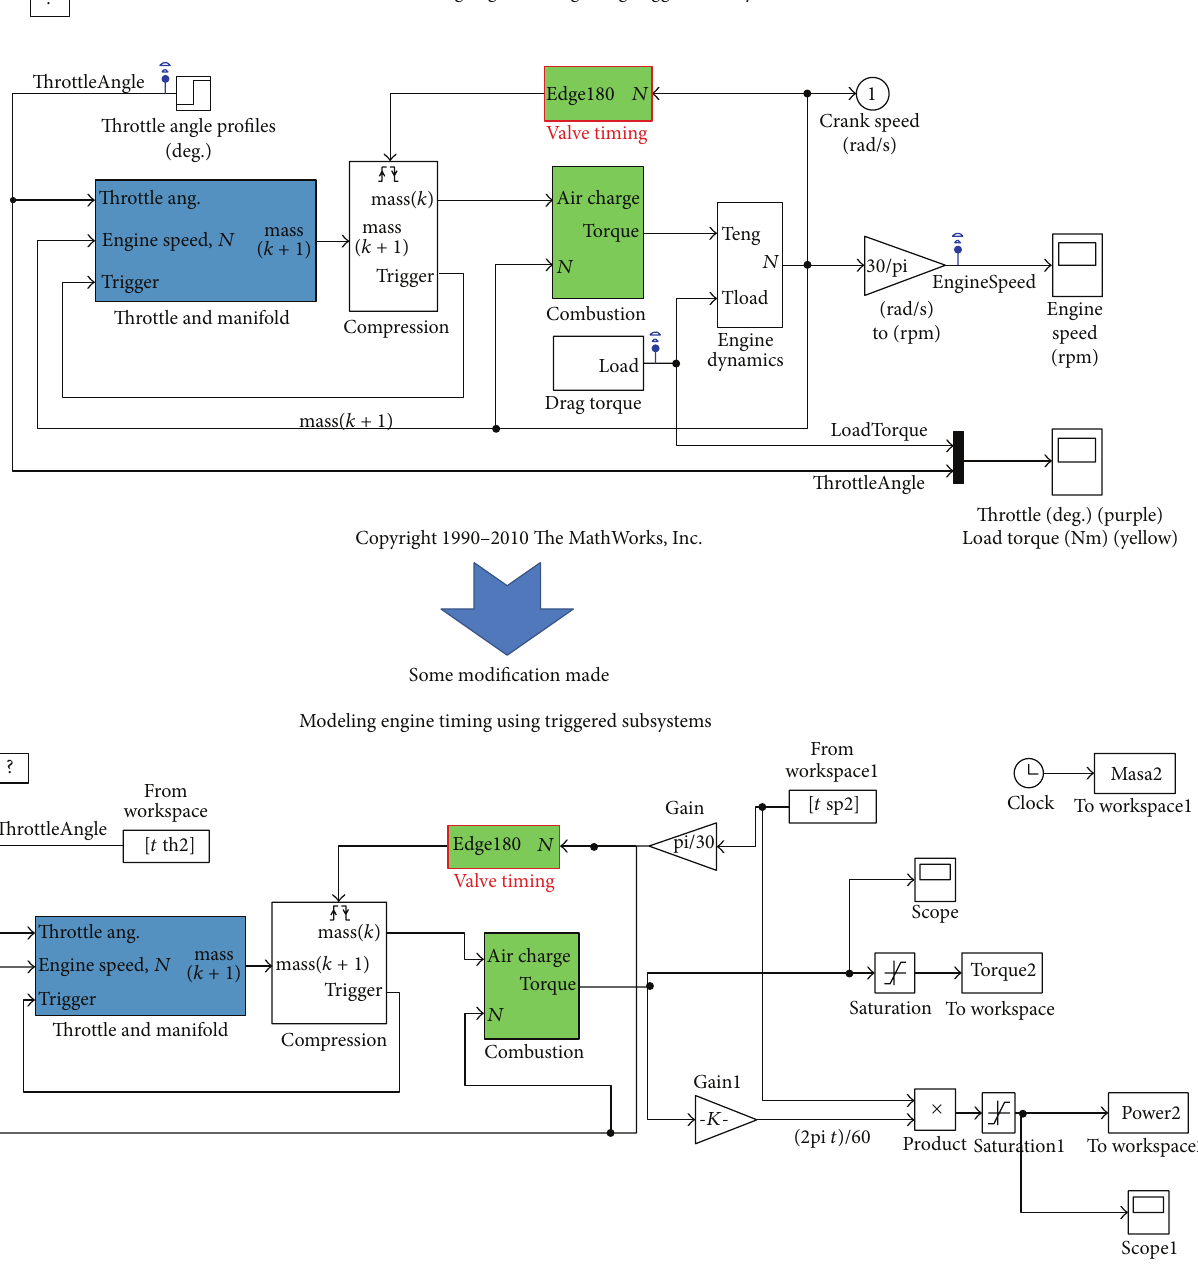
Figure 2: Modified demo Simulink